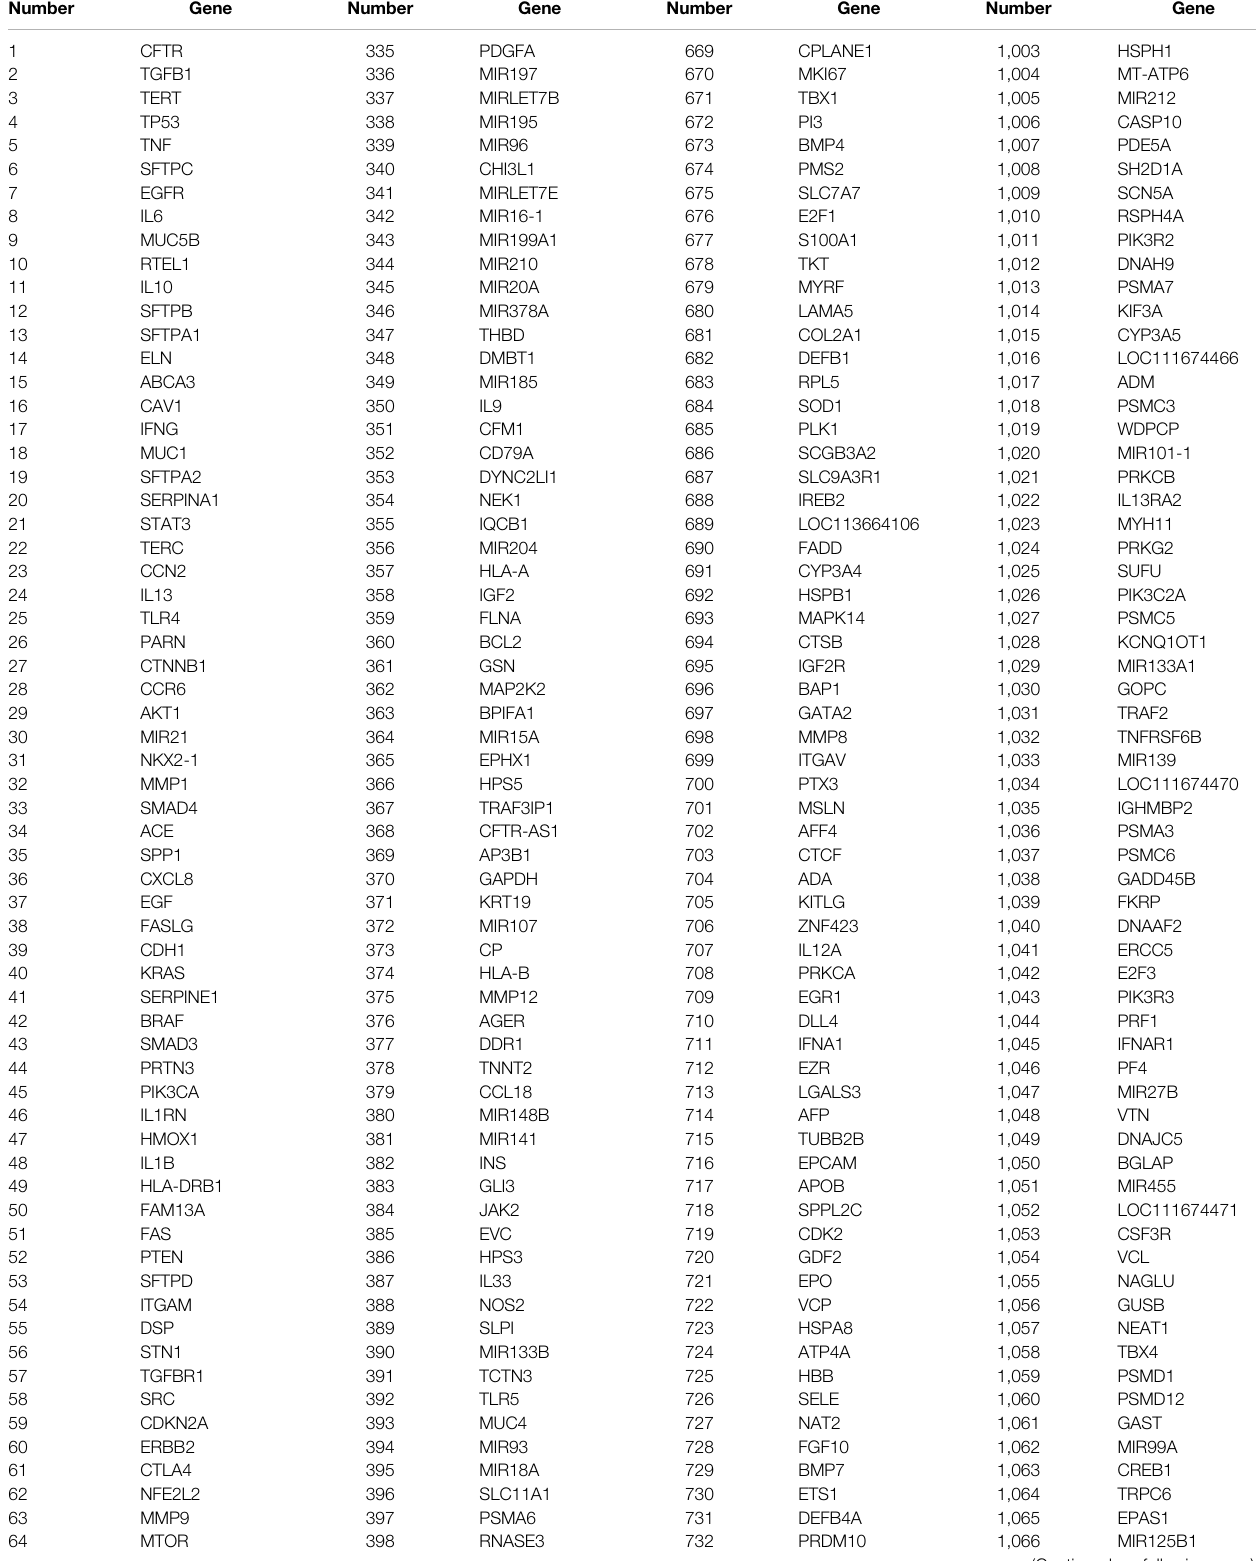
TABLE 3 | Lung fi brosis-related targets obtained from the GeneCards database.